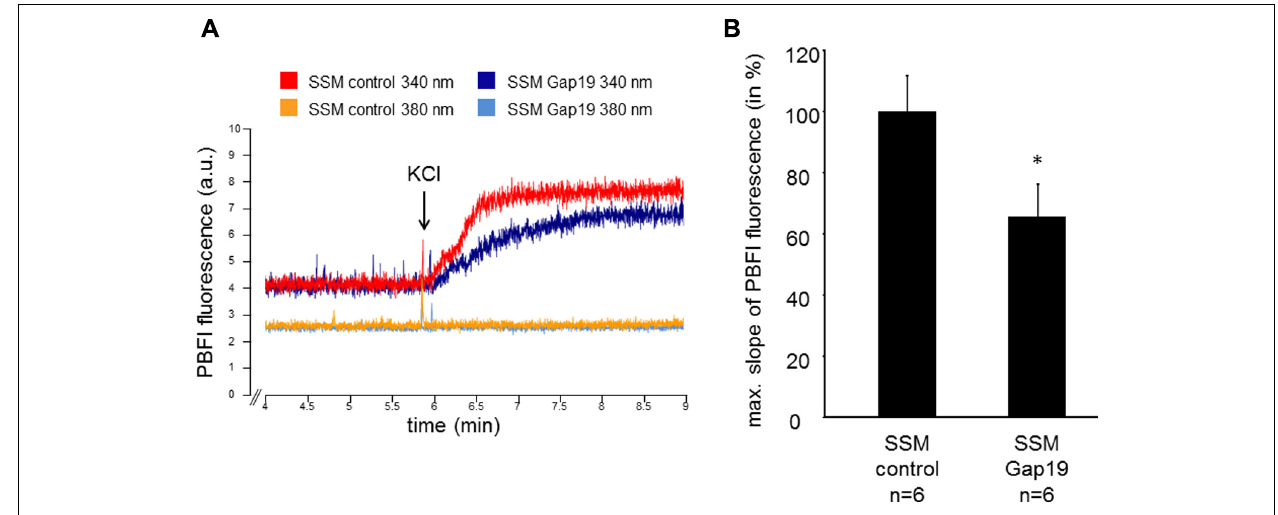
FIGURE 1 | Mitochondrial potassium uptake is decreased by Gap19. (A) Original traces showing PBFI fluorescence in arbitrary units (a.u.) before and after addition of 140 mM KCl of control- or Gap19-treated SSM at 340 and